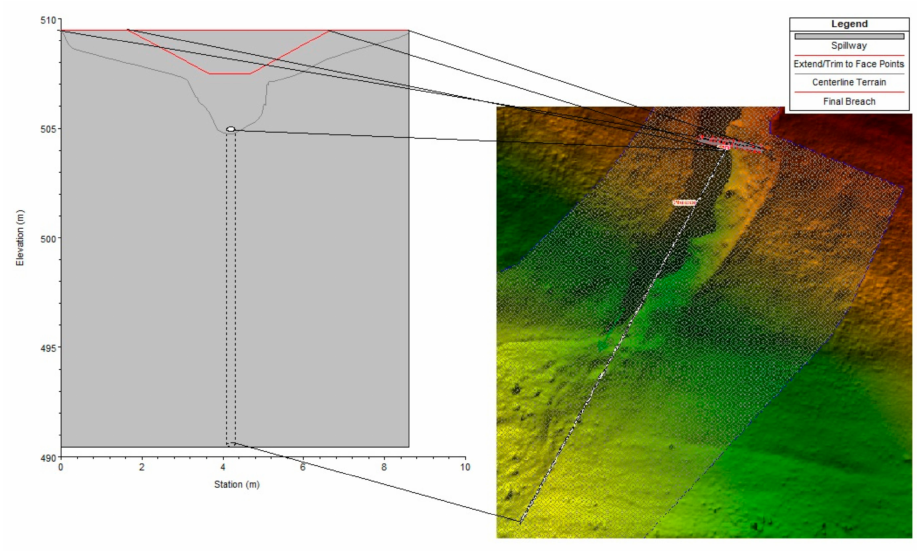
Figure 12. Dam technical characteristics simulation